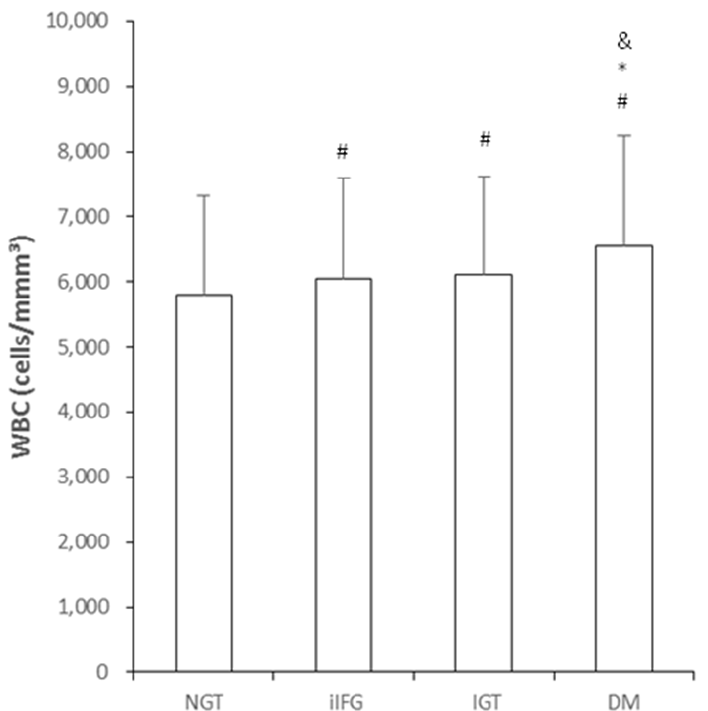
Figure 1. Comparisons of WBC counts between different groups. # indicated P < 0.05 compared with the NGT group. * indicated P < 0.05 compared with the iIFG group. & indicated P < 0.05 compared with the IGT